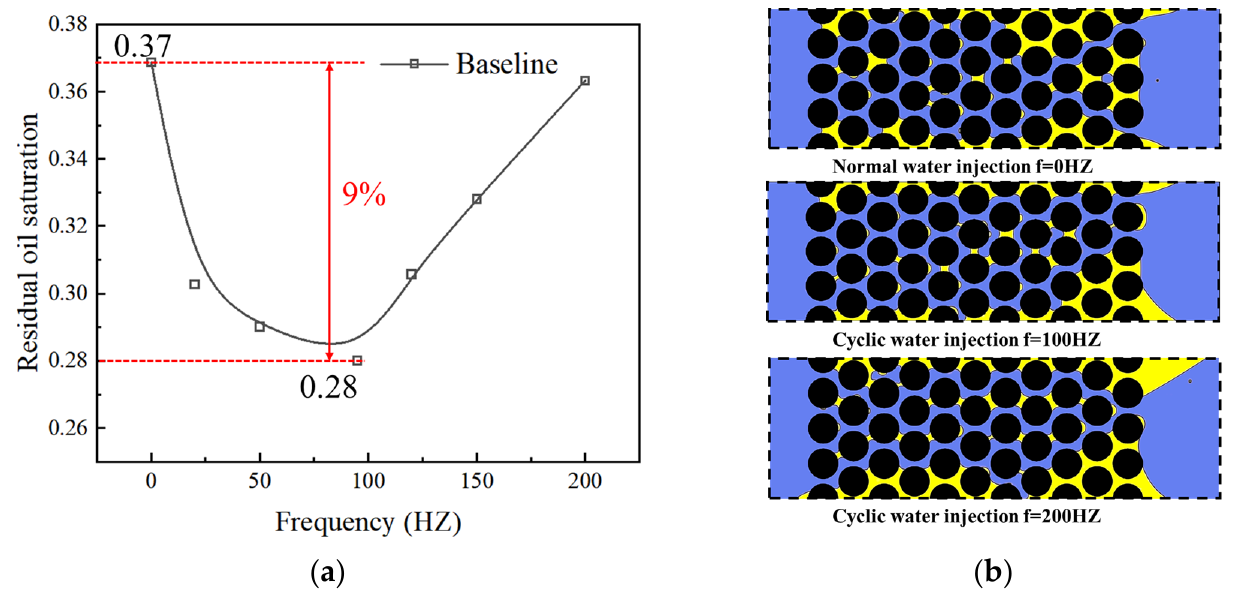
Figure 4. The effect of wave frequency on EOR. ( a ) The relationship between the frequency and the final remaining oil saturation. ( b ) The final remaining oil saturation of three typical frequencies.